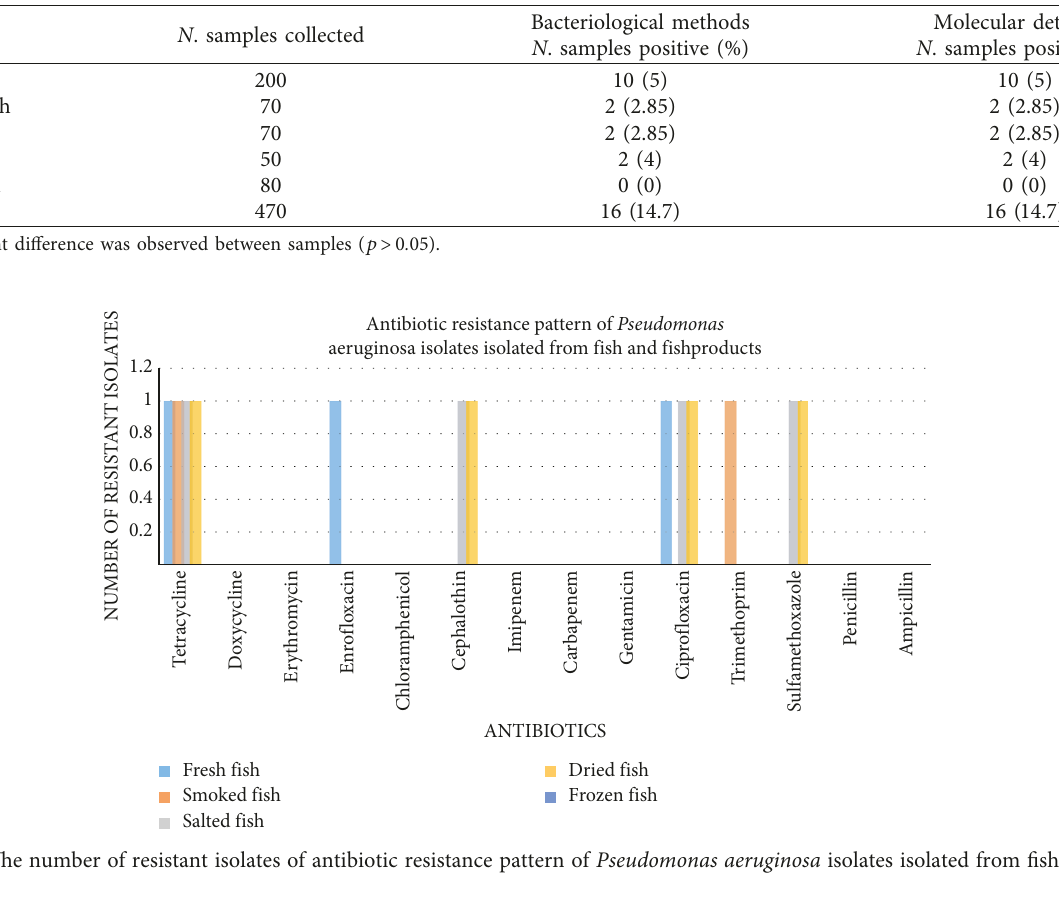
Table 2: The prevalence of Pseudomonas aeruginosa in types of fish. Sample N . samples collected